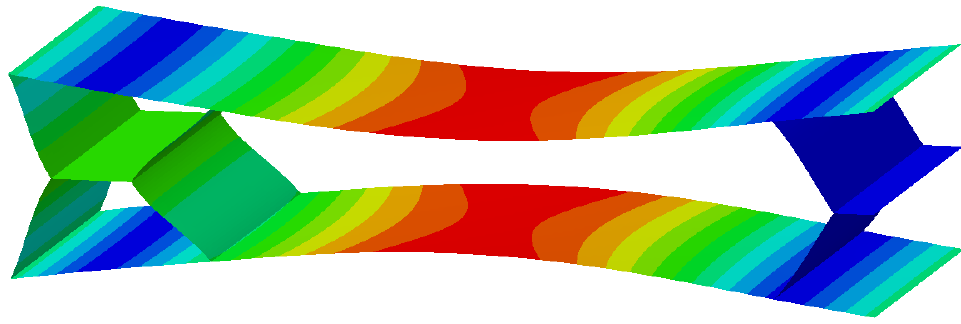
Figure 16. Displacement contour